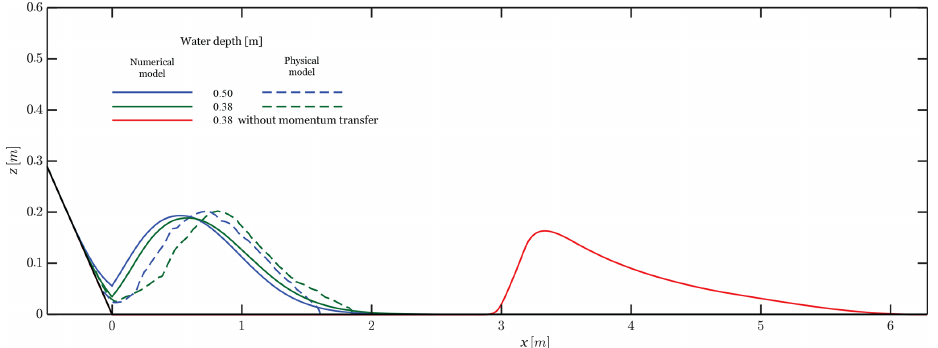
Figure 8. Cross section of the granular flow deposit for two still-water depths h (0.38 and 0.5m). For comparison, the red line illustrates the landslide deposit for a still-water depth h of 0.38m without momentum transfer (modified from Miller et al.,